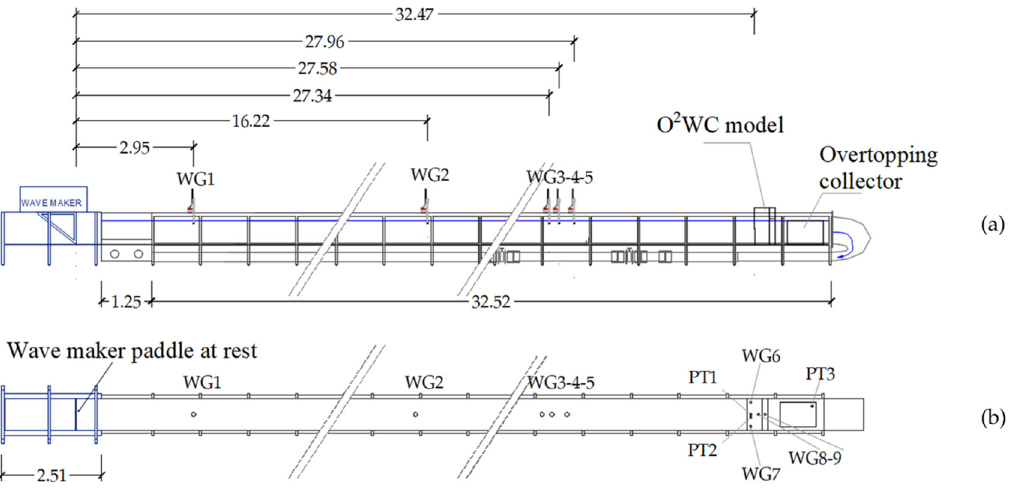
Figure 3. Position of the O 2 WC model and sensors installed the wave-current flume: longitudinal cross-section view ( a ) and top view ( b ). WG: ultrasonic wave gauge; PT: pressure transducer.